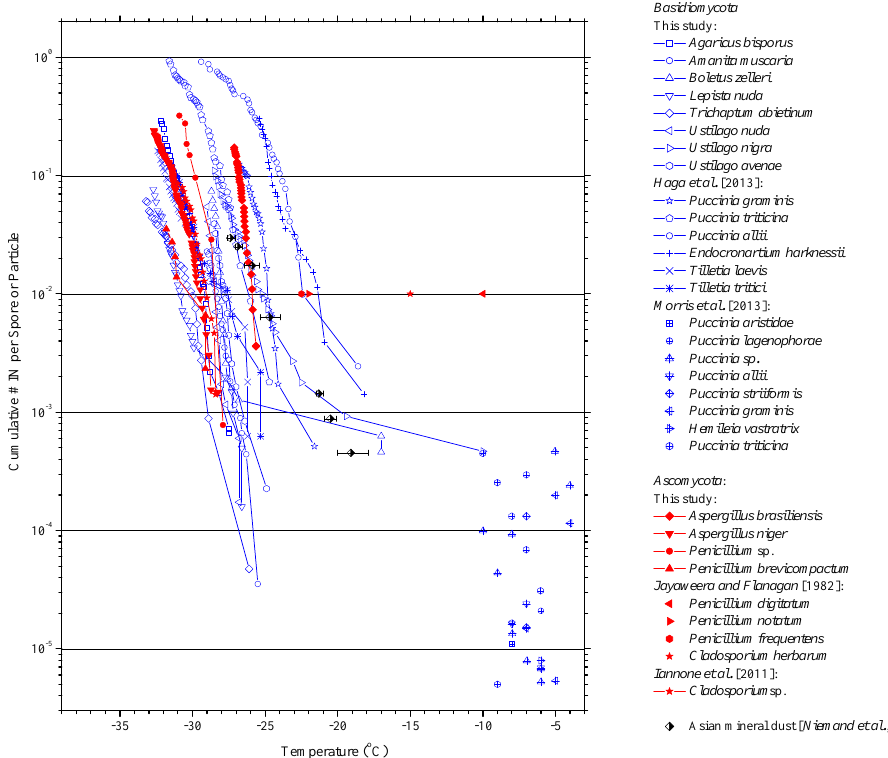
Figure 5. Comparison between the cumulative number of ice nuclei per spore as a function of temperature, INperSpore(T) , for Ascomycota and Basidiomycota spores investigated in this study and earlier studies, including Haga et al. (2013), Iannone et al. (2011), Jayaweera and Flanagan (1982), and Morris et al. (2013b). Also shown are INperParticle(T) values for submicron Asian mineral dust (Niemand et al.,